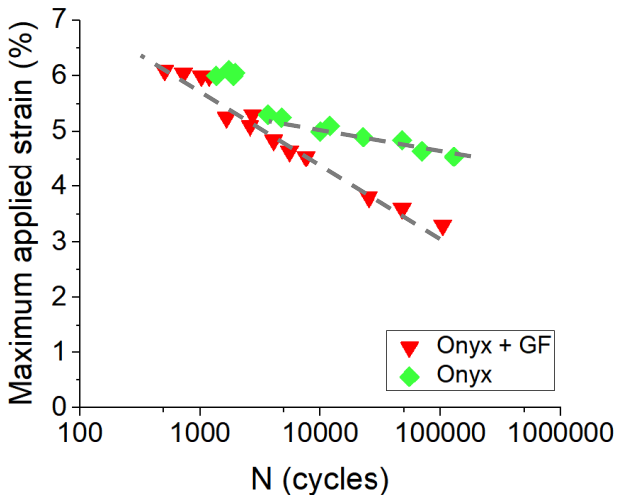
Figure 19. Obtained Wöhler curves concerning CF-PA6 reinforced with continuous glass fiber (Onyx + GF) and CF-PA6 (Onyx) specimens at 10 Hz [24].